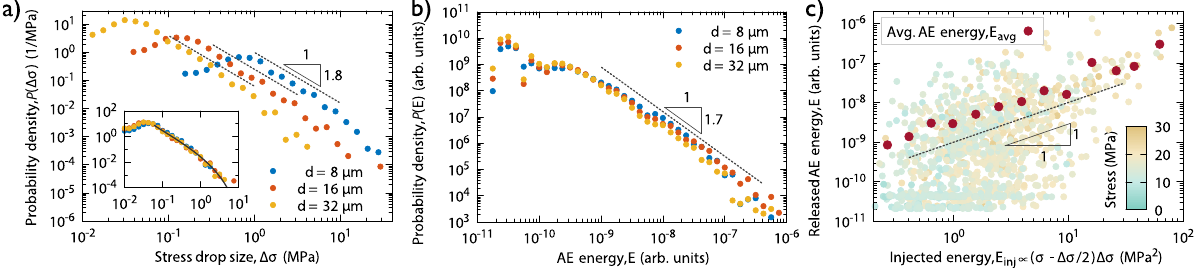
Fig. 2 Correlation between the stress drops and the acoustic signals. a Distribution of stress drop sizes Δ σ for different pillar side lengths d . The probability density functions (PDFs) follow a power-law with exponent τ σ = 1.8 ± 0.1. The inset shows the PDF as a function of the force drop Δ F = Δ σ ⋅ d 2 with units in mN. The collapsed curves can be fi tted with a master function above the detection threshold and exhibit a cut-off at F 0 = 1.5 ± 0.1 mN. b Distribution of AE energies of individual signals detected at the sample surface. The curves are characterized by a power-law exponent τ E = 1.7 ± 0.1 and do not exhibit an apparent cut-off and do not depend on the pillar side length d . c Scatter plot of the injected energies E inj during stress drops of d = 32 μ m pillars and the corresponding summed released AE energies E . The color-scale refers to the actual stress at which the stress drop took place along the stress-time curve and do not show correlation with the injected energy. The red dots represent the average released energies E avg obtained by averaging the datapoints for bins of logarithmically increasing width. The dashed line represents the E ∝ E inj linear relationship.